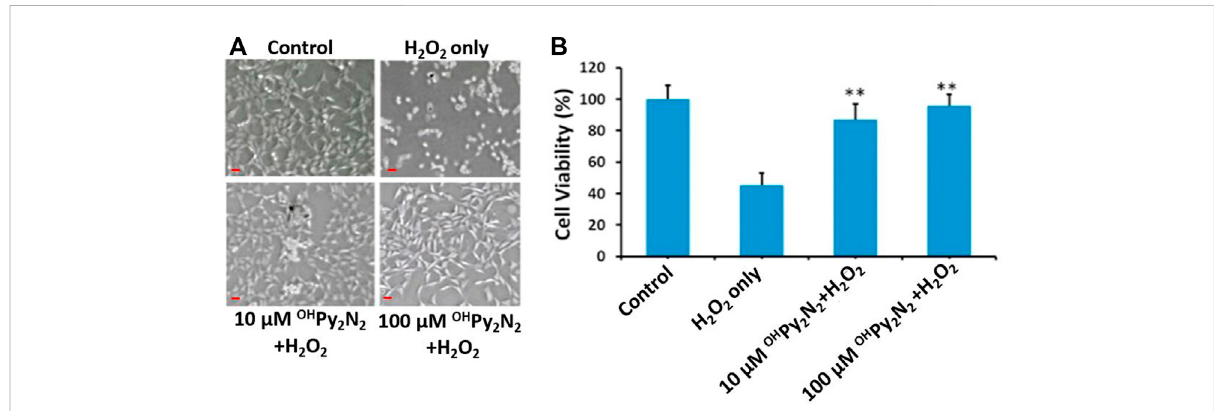
FIGURE 2 Cytoprotective effects of OH Py 2 N 2 in primary LEC against treatment with H 2 O 2 . Cells were incubated with or without OH Py 2 N 2 (10 and 100 µM) for 24 h and then treated with 200 µM of H 2 O 2 for 6 h. After treatment, 10 µL of WST-8 solution was added to each well of the culture plate and incubated for 2 h in the incubator. (A) Images of cells (Scale bar = 50 µm), (B) Cell viability. n = 6, ** p <